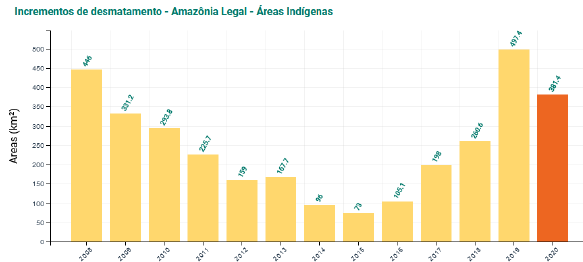
Figure 2 - Output map derived from TerraBrasilis platform showing PRODES deforestation increments in indigenous lands in the BLA between 2008-2020.